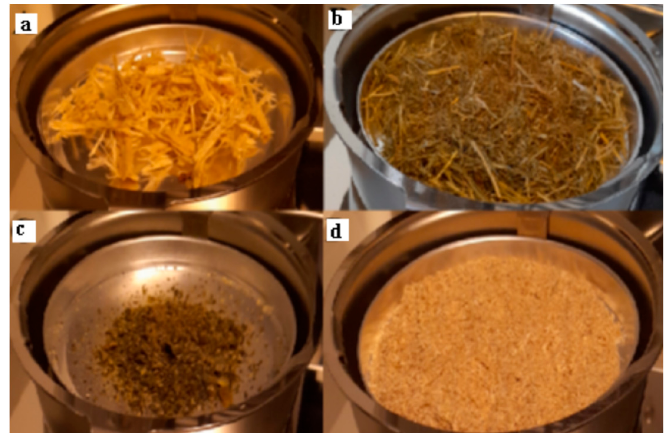
Figure 2. ( a )Wood chips; ( b ) Hay; ( c ) Seaweed; ( d ) Sawdust.